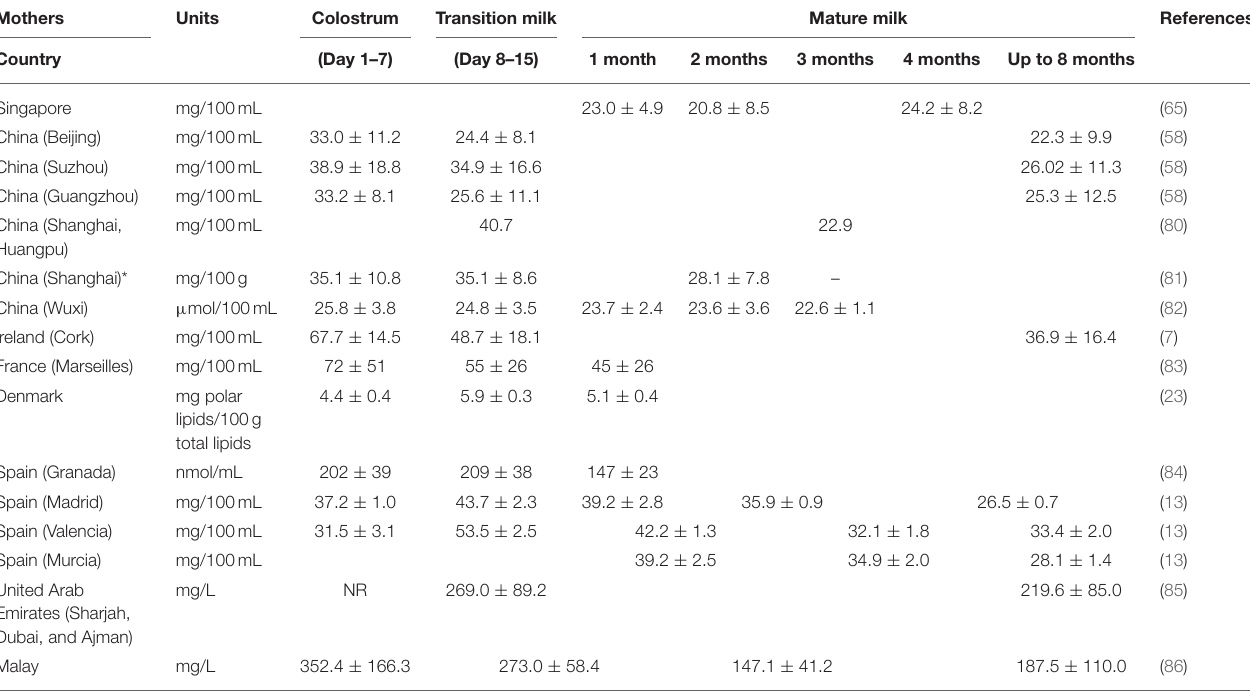
TABLE 1 | Total phospholipid concentration in human colostrum, transitional, and mature milks. Mothers